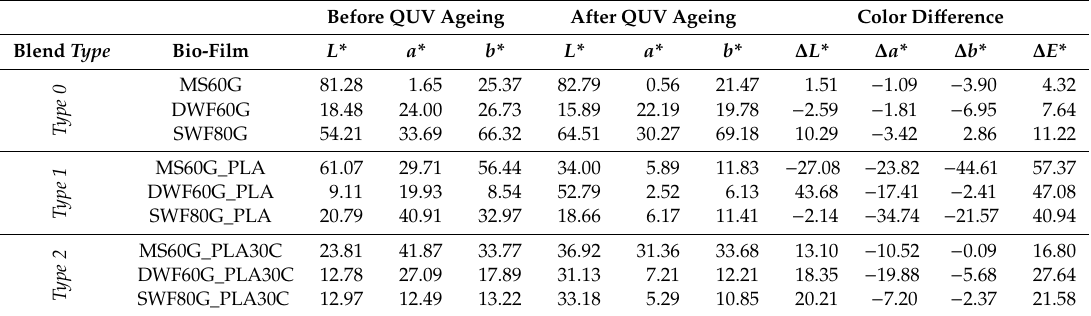
Table 5. Color data of maize starch (MS)-based, durum waste flour (DWF)-based and soft waste flour (SWF)-based bio-films before and after QUV ageing.